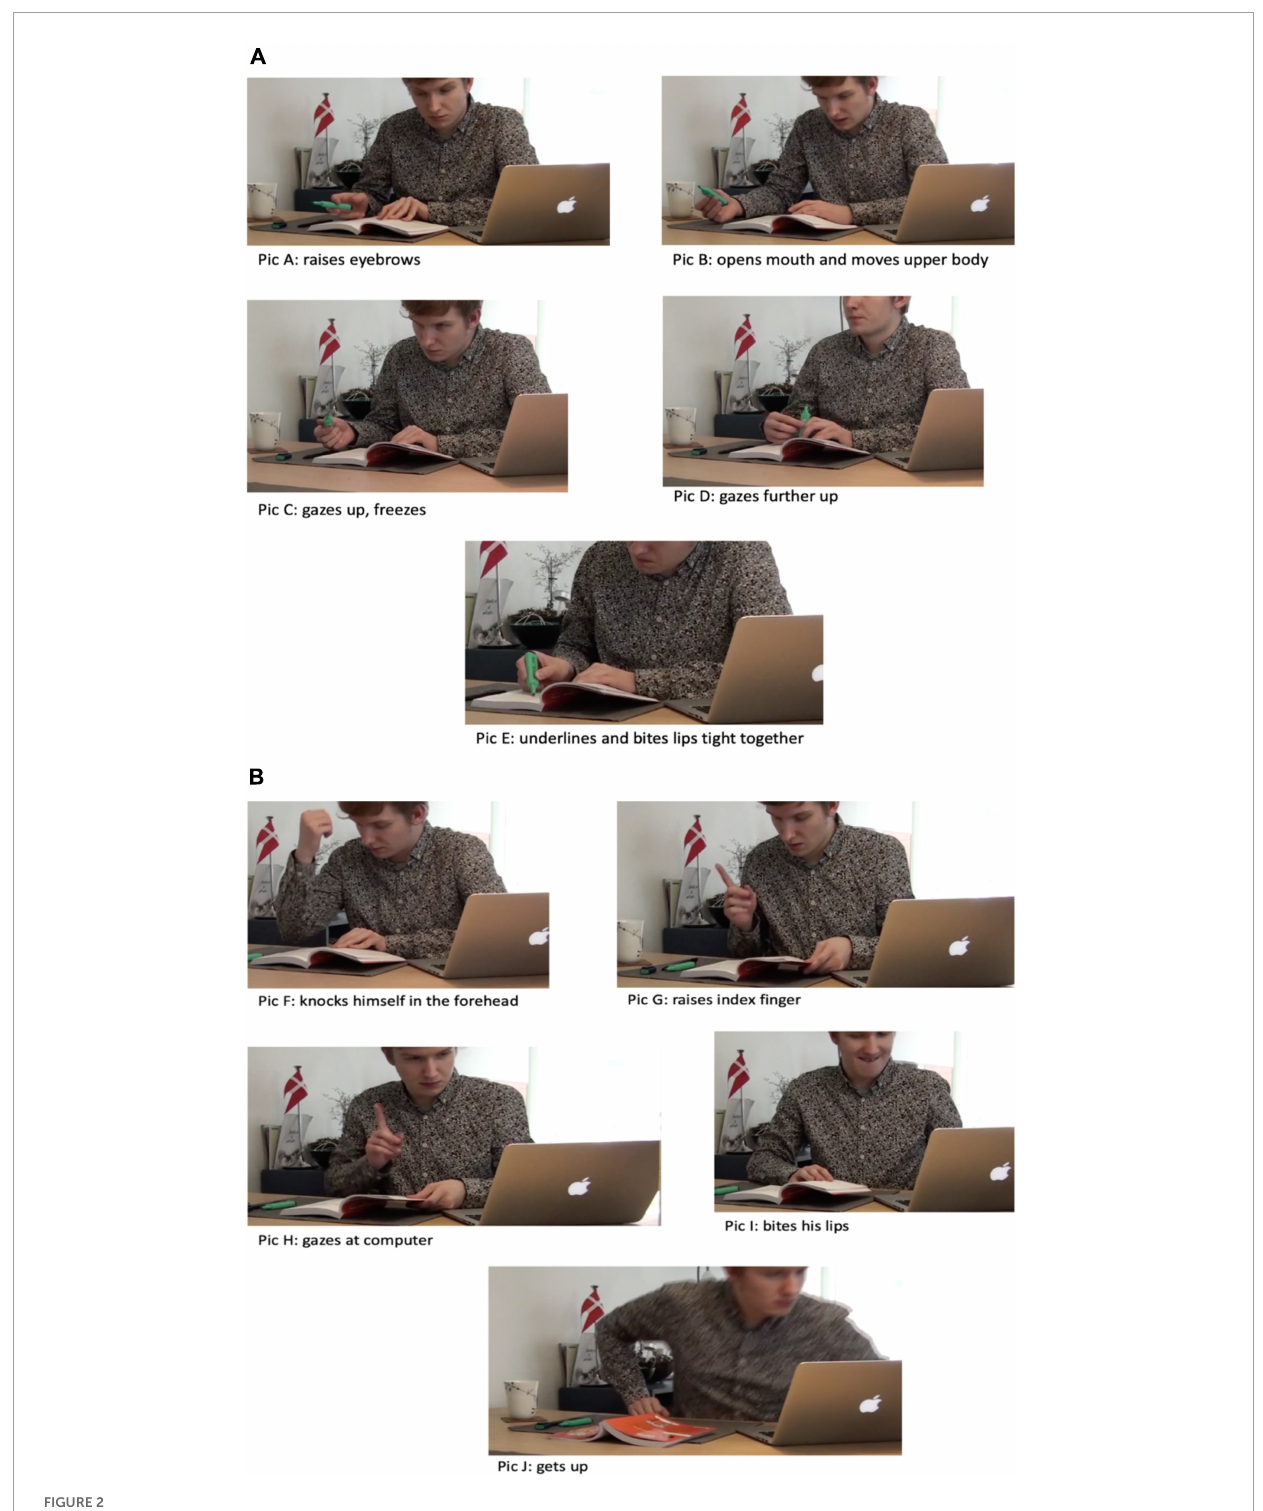
FIGURE2 (A,B) Breaks from visual perception of symbols in the text.